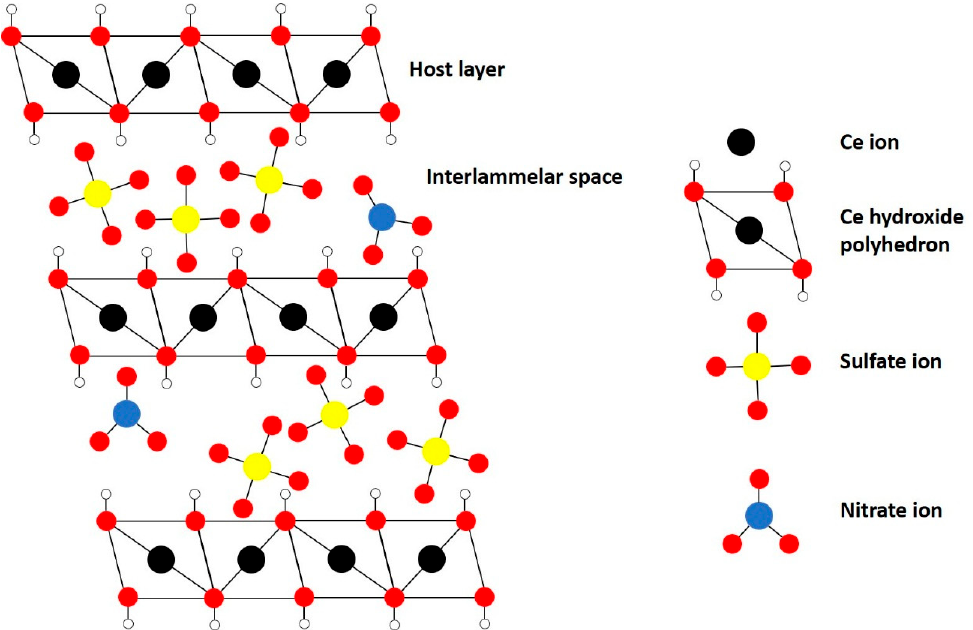
Figure 2. Structure of monometallic Ce-LDH.